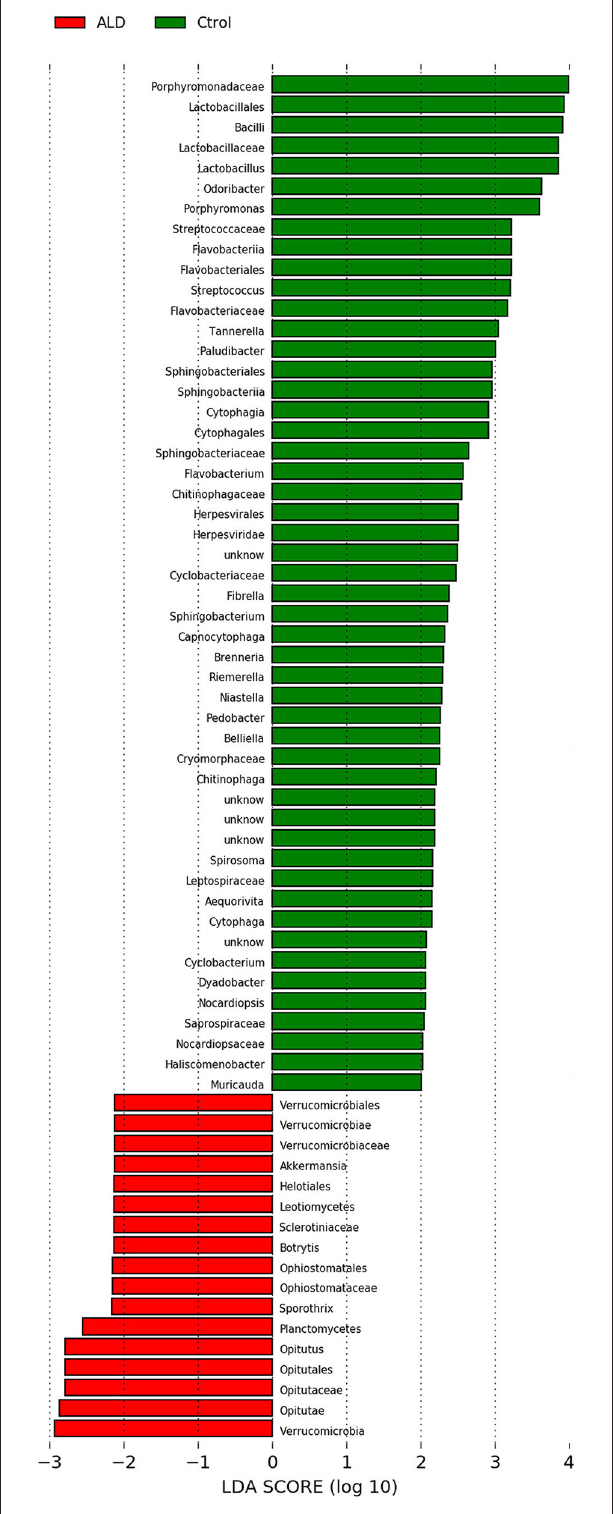
FIGURE 4 | Linear discriminant analysis (LDA) effect size (LEfSe) analysis revealed significant bacterial differences in fecal microbiota between the ALD (positive score) and control groups (negative